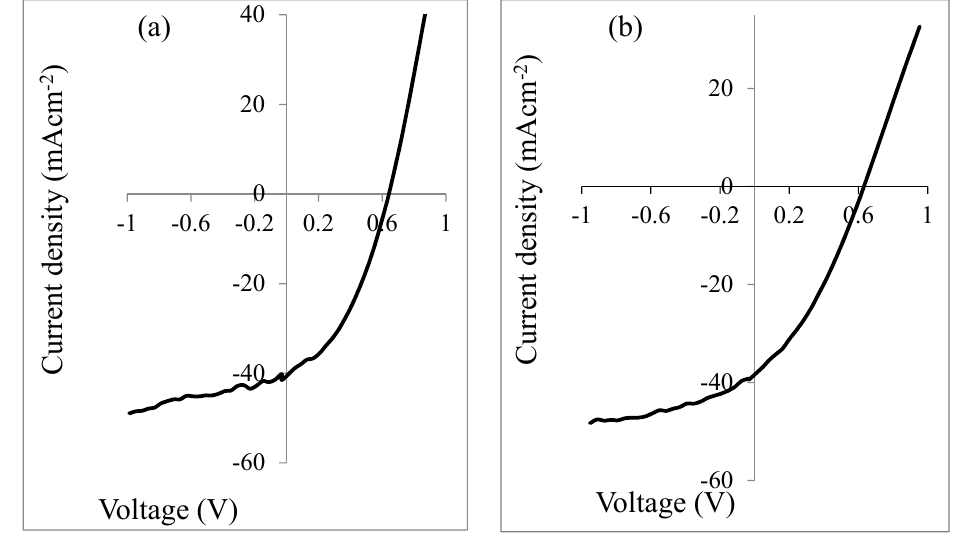
Figure 9. I-V characteristics of ( a ) glass/FTO/ZnS/CdS/CdTe/Au 3-layer graded bandgap solar cell and ( b ) glass/FTO/CdS/CdTe/Au 2-layer solar cell under AM 1.5 illumination conditions at room